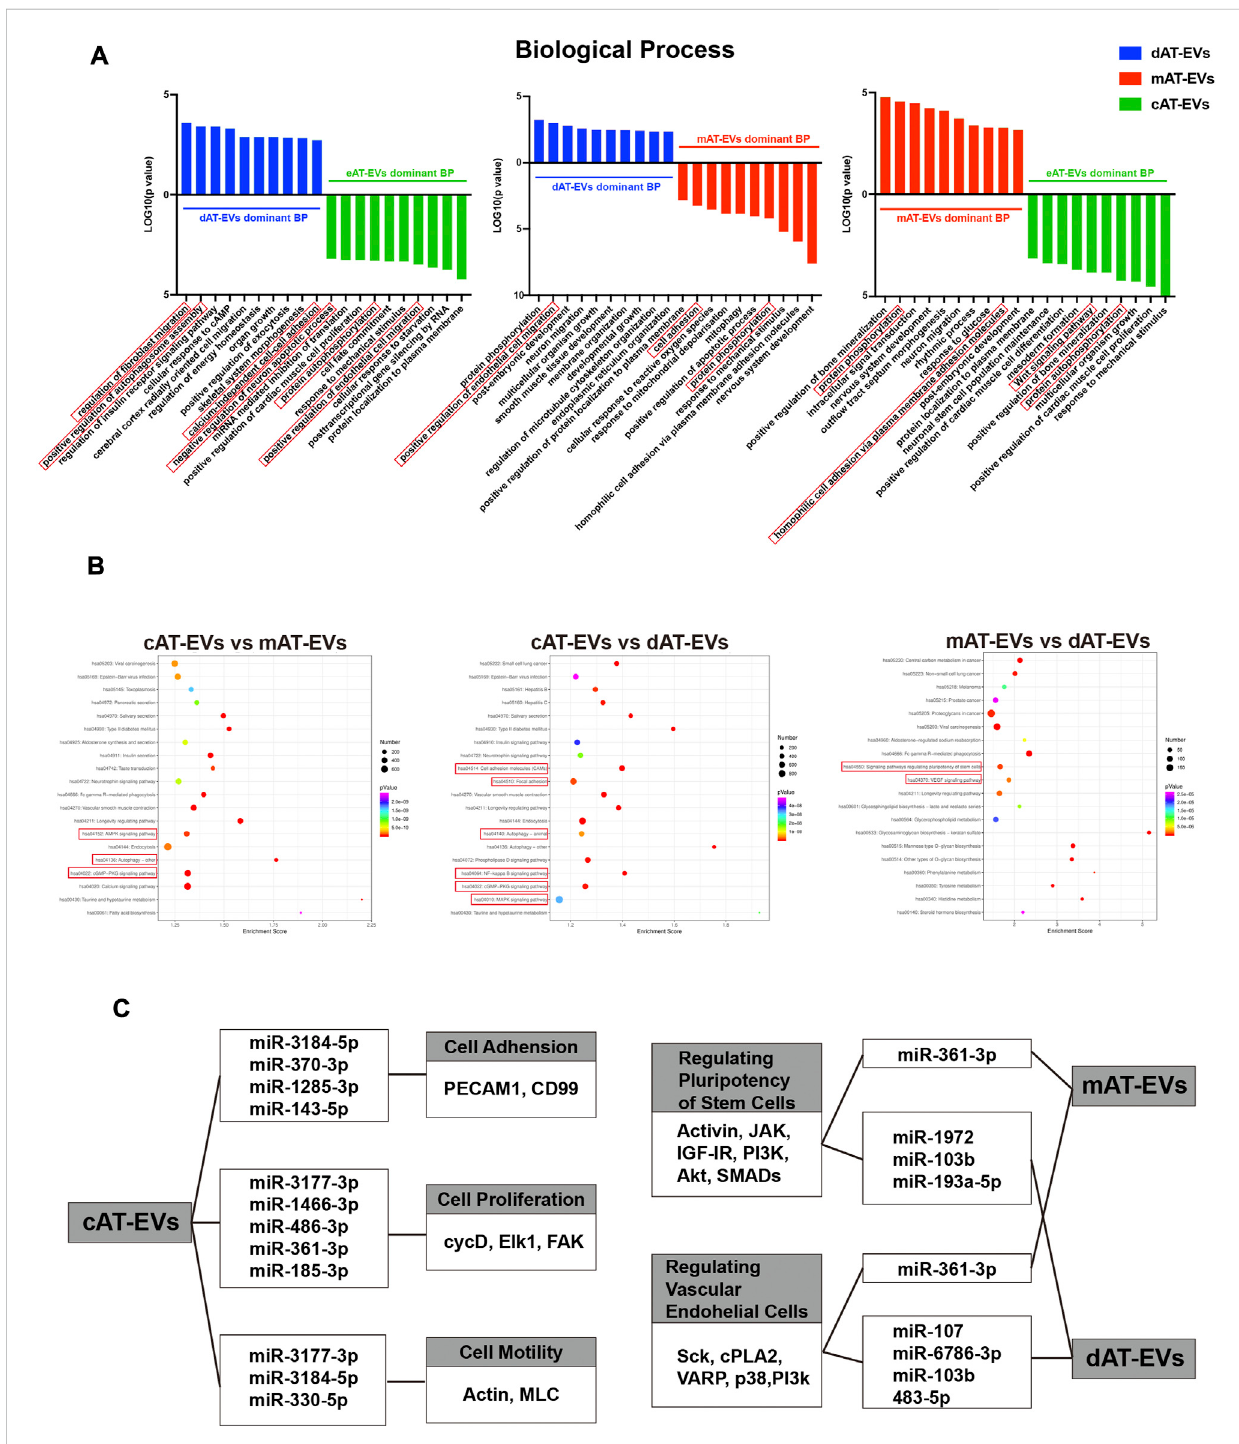
FIGURE 10 GeneOntology(GO)andKyotoEncyclopediaofGenesandGenomes(KEGG)analysesofmiRNAinAT-EVs (A) GOanalysisofpredicteddifferentially expressed genes of biological processes, based on the identi fi ed differentially expressed miRNAs. (B) KEGG pathway analysis of differentially expressed genes. The 20 most enriched terms are presented as bubble charts and the wound healing-associated pathways, highlighted (C) Enriched functions and pathways associated with wound healing, with their corresponding miRNAs and differentially expressed genes. TPM: transcripts per